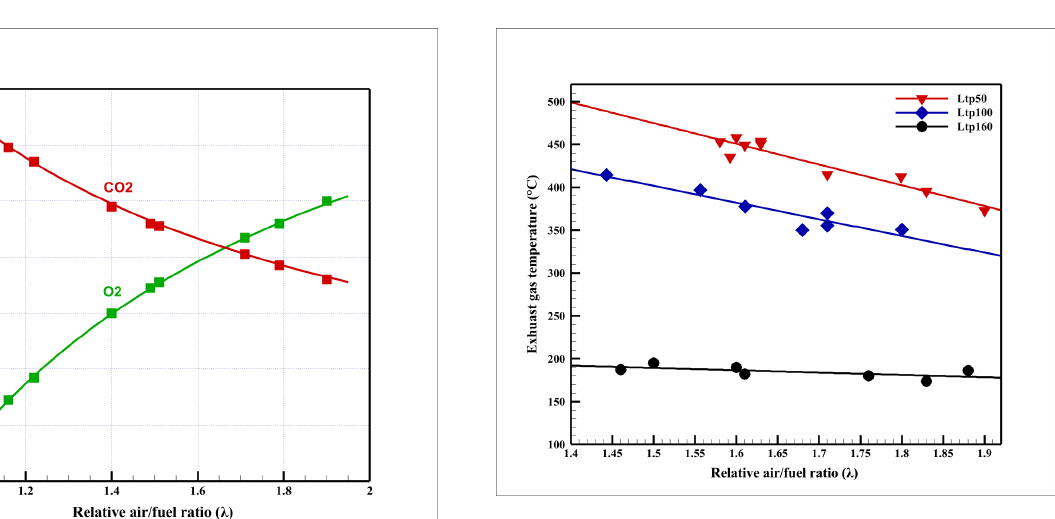
Fig. 9. Variation of exhaust gas temperature with equivalence ratio for different tailpipe lengths